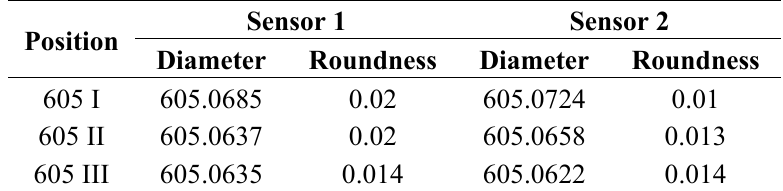
Table 4. Results measured in the field using the two sensors